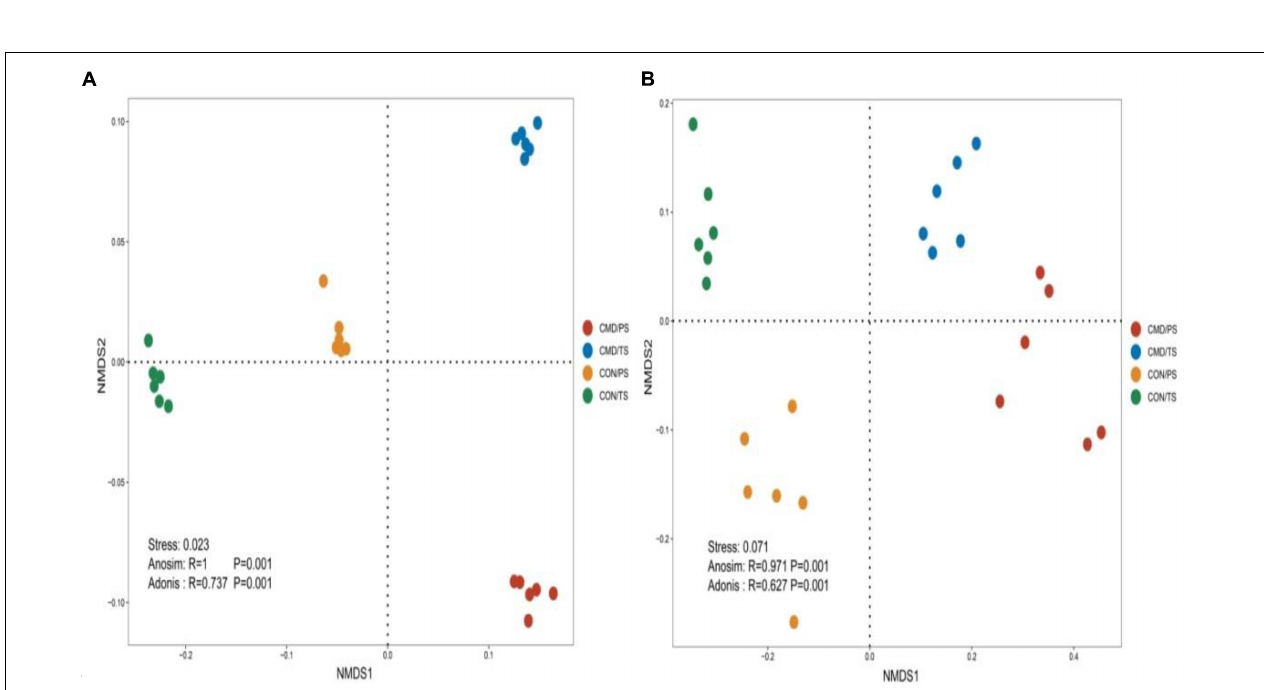
FIGURE 3 | Non-metric multi-dimensional scaling (NMDS) of the bacterial (A) and fungal (B) community structures in CON and CMD treatments at various growth stages. TS, plant trefoil stage (15 days after sowing); PS, plant pustulation stage (66 days after sowing). CON, control; CMD, cattle manure deposition.